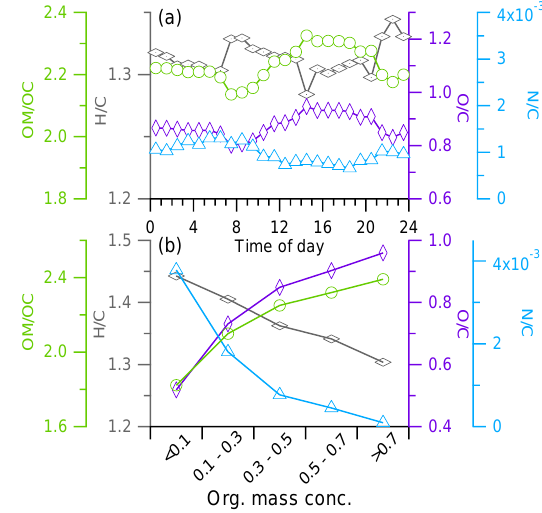
Figure 9. (a) Diurnal variations of elemental ratios and (b) the vari- ations of elemental ratios as the function of mass concentration of organic